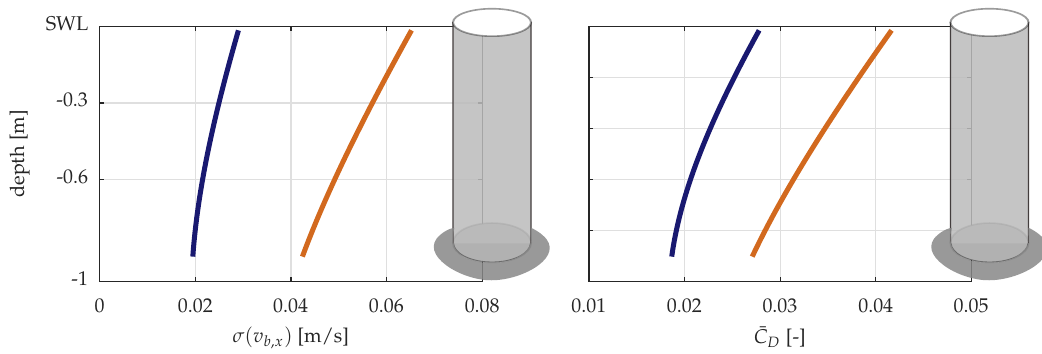
Figure 4. Horizontal body velocity Standard Deviation (STD) σ over column length ( left ) and obtained linearized drag coefficients ¯ C D ( right ) for two sea states, Load Case (LC) 7 (dark blue) and LC 9 (light orange) as used in the scaled experiment of [39]. The TripleSpar column with heave plate illustrates the vertical axis in body coordinates.